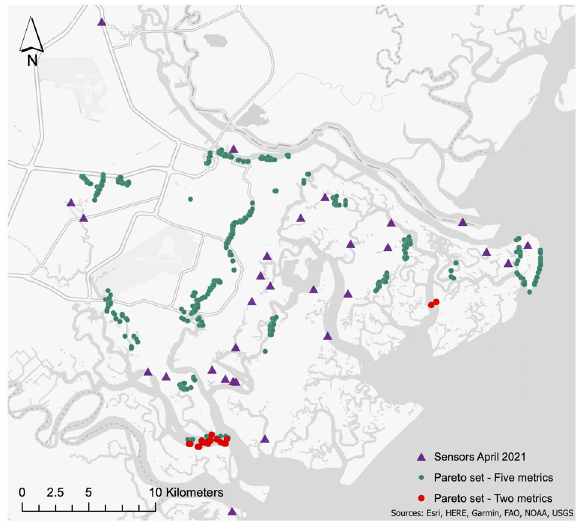
Fig. 5 Comparison between identi fi ed prioritized potential new sensor locations using traditional two metrics of coverage and uncertainty and using new metrics covering sensor-related, fl ood-speci fi c, and social parameters as proposed in this study. Existing sensor locations (purple triangles); prioritized Pareto set of potential new sensor locations based on only two metrics of coverage and uncertainty (red circles); and prioritized Pareto set of potential new sensor locations based on the full set of fi ve metrics as proposed in this study including network coverage, network uncertainty, critical infrastructure facilities density, fl ood likelihood, and Damage Assessment Priority Index (DAPI) ranking social vulnerability (green